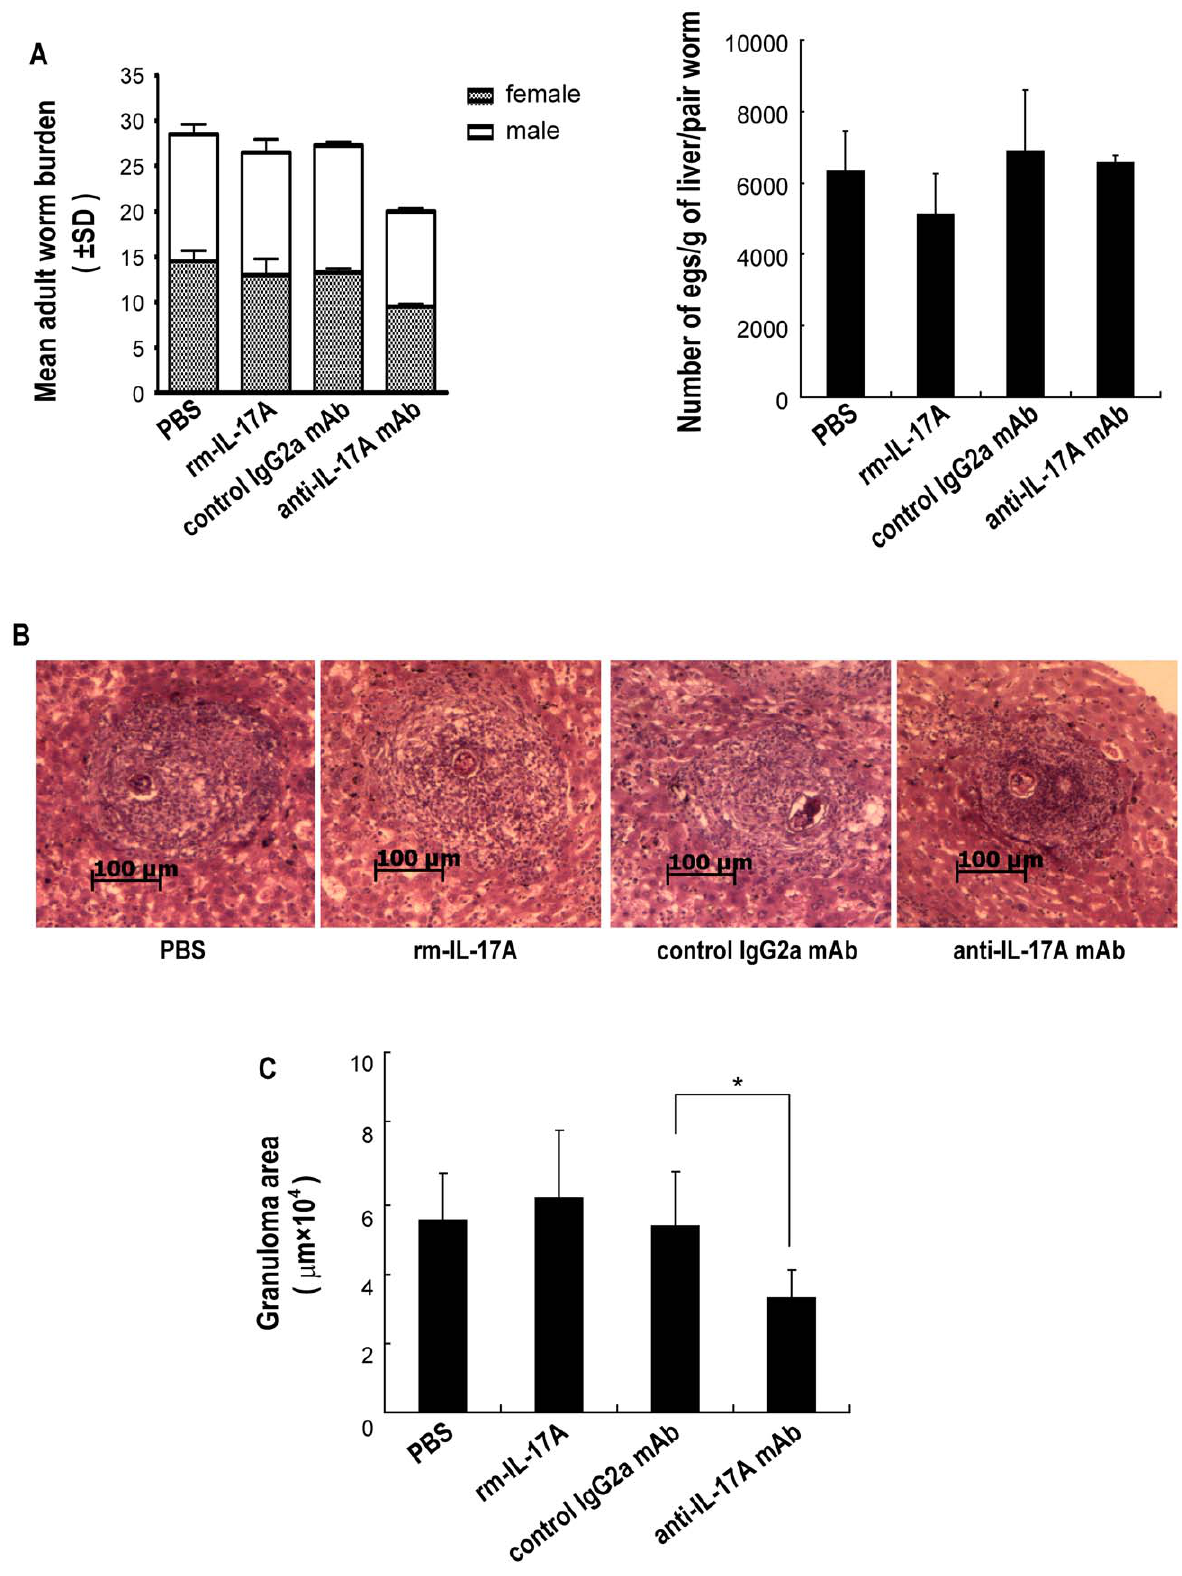
Figure 5. Protection against S.japonicum infection in C57BL/6 mice administered rmIL-17A or anti-IL-17A neutralizing mAb. rmIL- 17A, anti-mouse IL-17A mAb or controls were administered to mice, followed by challenge with 40 S. japonicum cercariae per mouse. A. Six weeks after the challenge, the mice were sacrificed and perfused to collect adult worms. The numbers of eggs extracted from the liver were determined by microscopic examination. Protection was measured by assessing the worm and egg burden. Values are given as mean 6 SD of eight mice from two